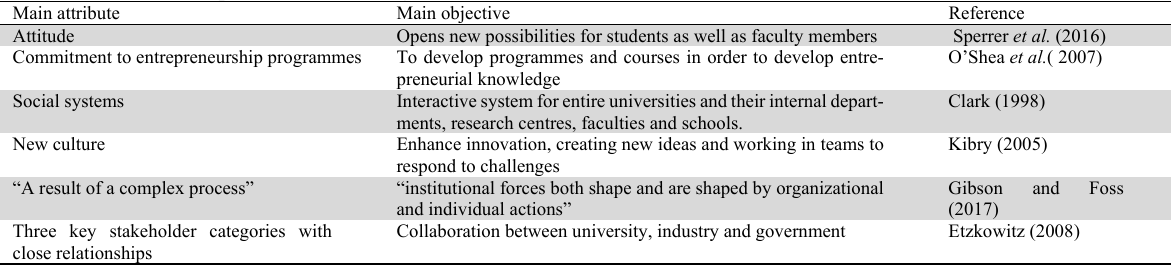
Definitions of the entrepreneurial